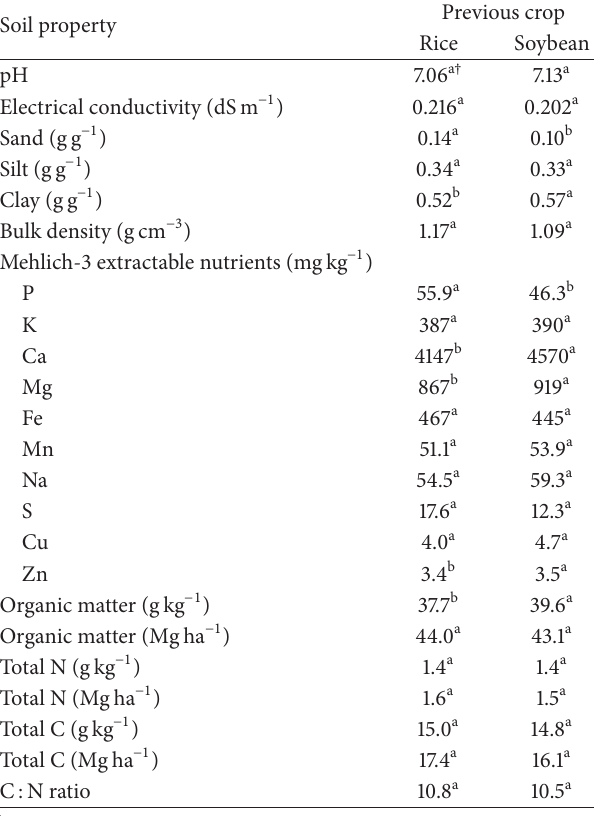
Table 1: Mean soil properties ( 𝑁 = 12 for each previous crop) prior to flood establishment from Sharkey clay during the 2013 growing season at the University of Arkansas Northeast Research and Extension Center in Keiser, Arkansas.